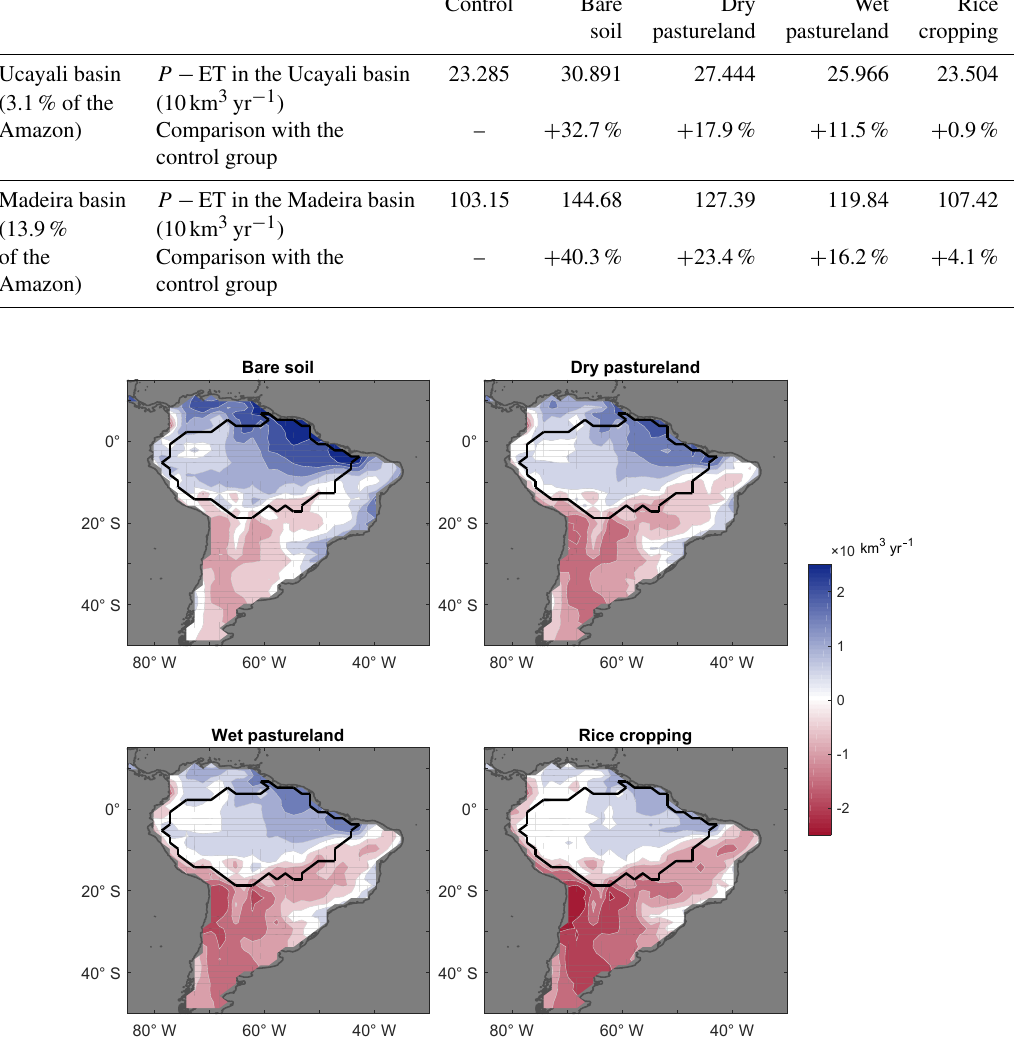
Figure 6. Spatial patterns in local runoff ( P − ET) changes compared to the control state for land use scenarios applied in the Amazon basin. Runoff generally increases in all scenarios (especially in the north-eastern part of the Amazon basin) but the rise is less pronounced in the rice cropping scenario over